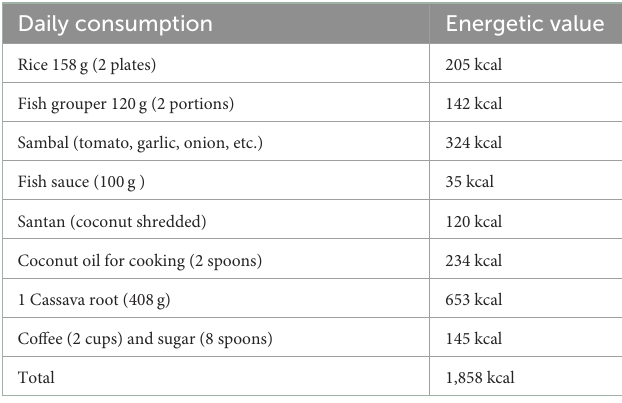
TABLE 1 Example of daily consumption.